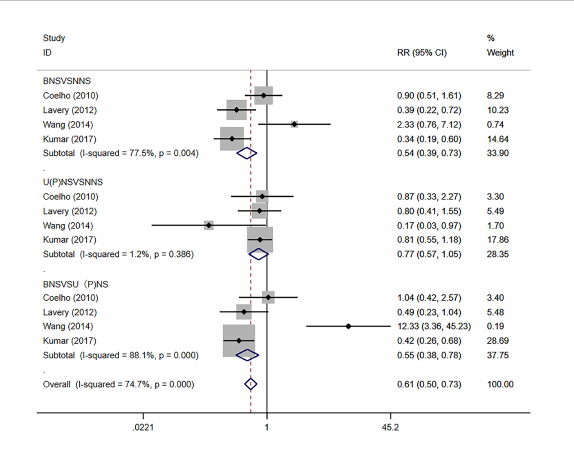
FIGURE 5 Forest plots of PSM Subgroup analysis for nerve sparing (NS) versus non-nerve sparing. CI, con fi dence interval; RR, Risk Ratio; PSM, positive surgical margins.